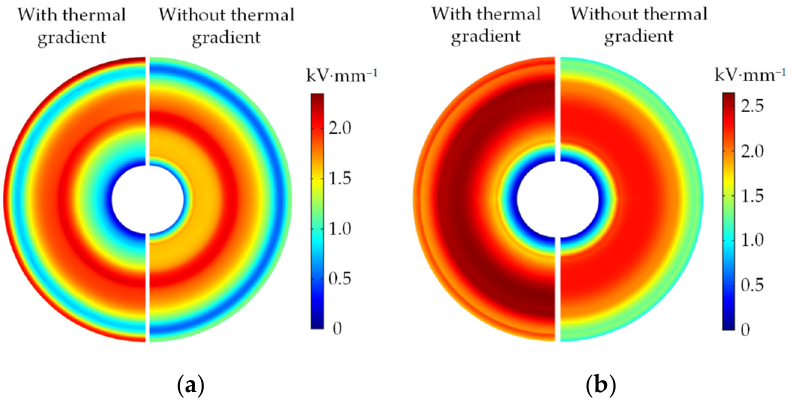
Figure 16. The influence of the thermal gradient on the electric field distribution of the spacer surface. ( a ) Concave surface; ( b ) Convex